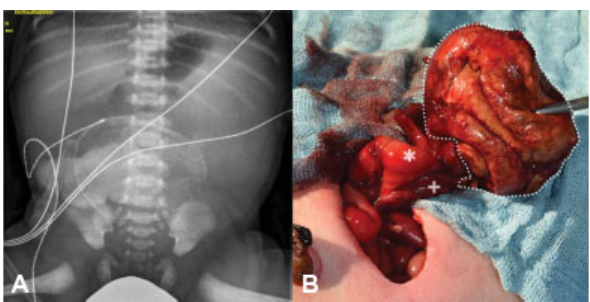
Fig. 1 Preoperative plain abdominal fi lm (A) and intraoperative fi ndings (B). Meconium pseudocyst, the dilated prestenotic jejunum ( (cid:3) ), and unused small poststenotic jejunum ( þ ) at the base of the pseudocyst. Note the substantial caliber difference.